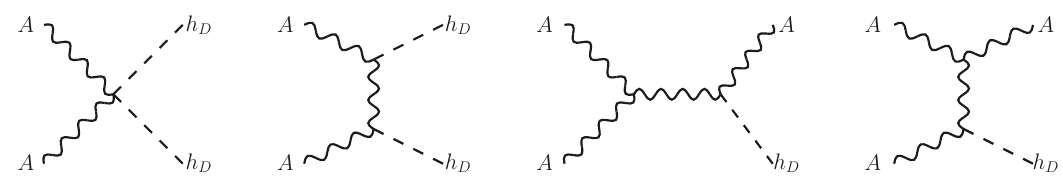
and (cid:18) (cid:28) D